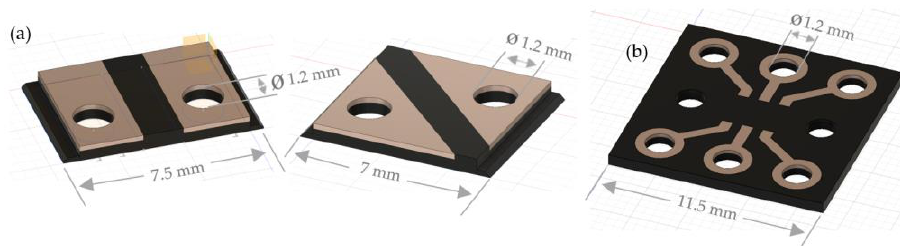
Figure 14. 3D sequin designs for ( a ) LEDs and ( b ) RGBs.